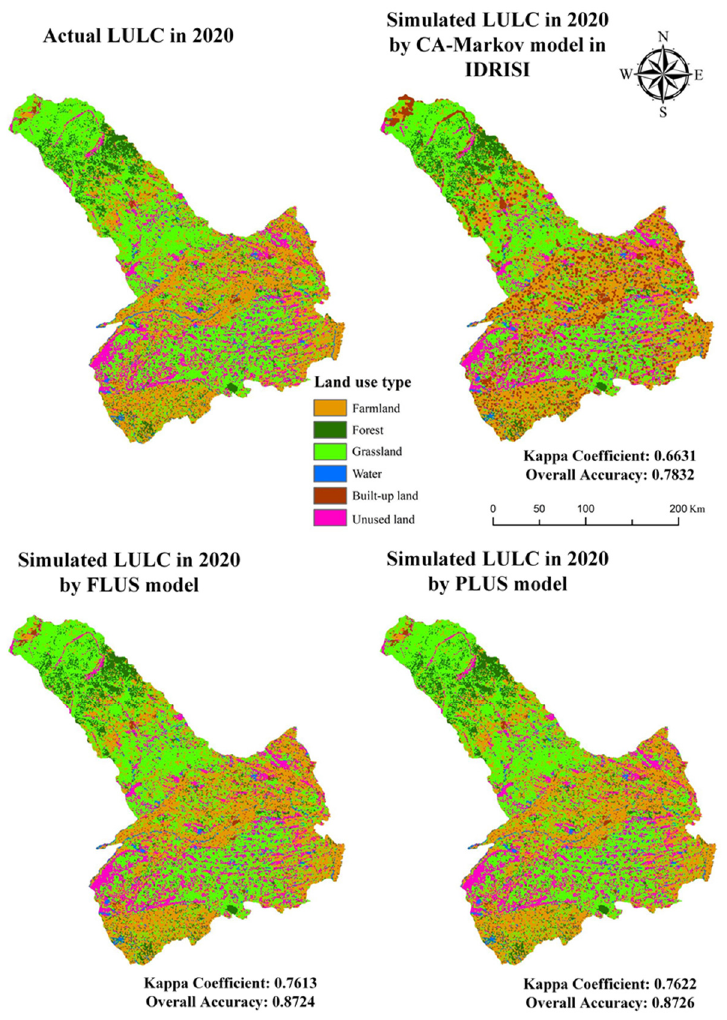
Figure 5. Distribution maps of LULC simulation in Tongliao using different models.